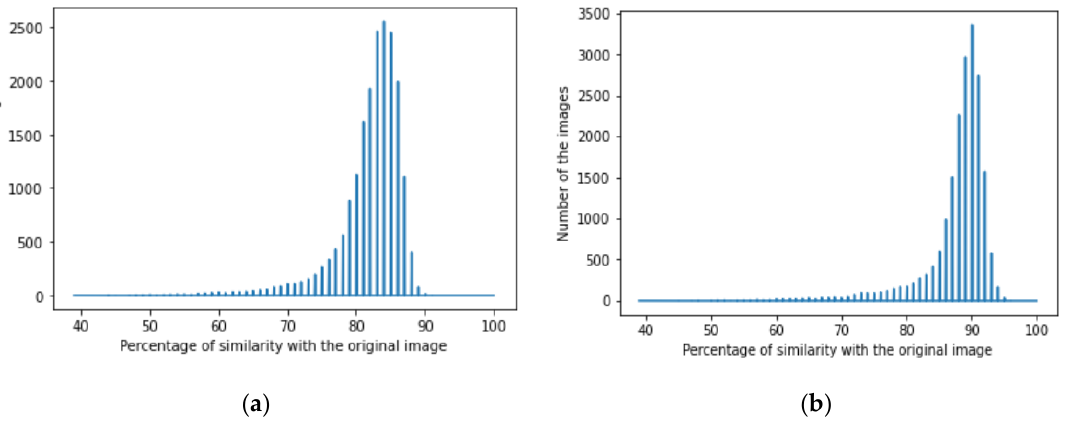
Figure 10. The histogram of similarity between the predicted denoised image and the original image in the case of speckle noise: ( a ) one autoencoder with separable convolutional neural networks; ( b ) dual autoencoder with separable convolutional neural networks.